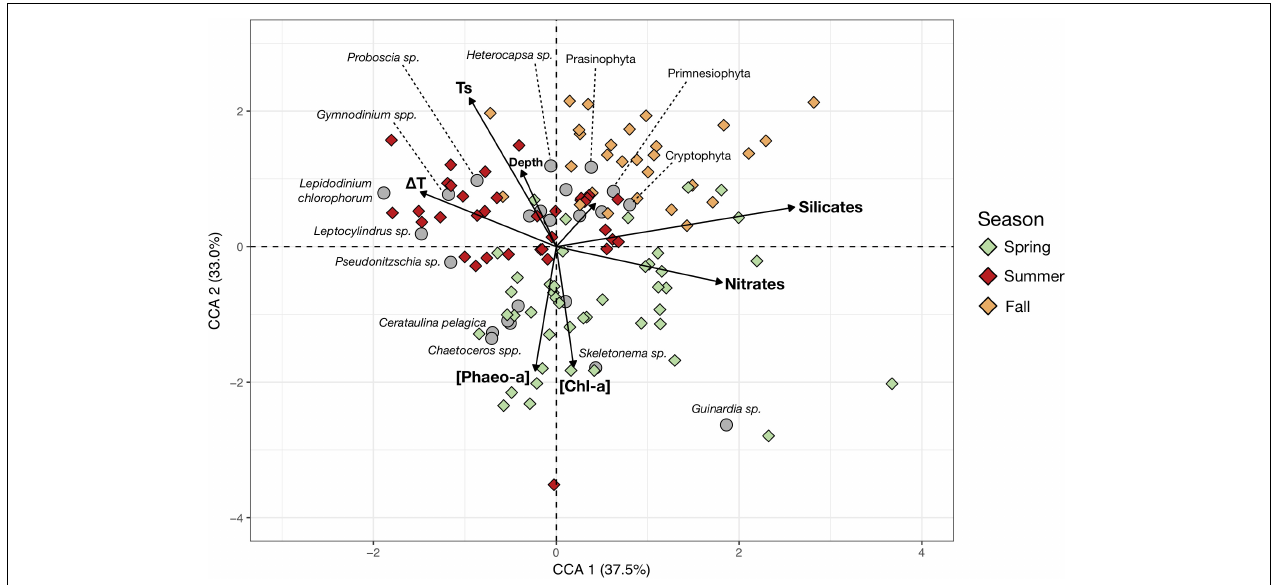
FIGURE 4 | Canonical Correspondence Analysis (CCA) based on the cells counts (cells/mL) of the main phytoplankton species and genera (response variables) and the measured hydrobiological data (explanatory variables, arrows). The color of the symbols corresponding to sampling stations (objects) were colored according to sampling season (Spring, Summer, and Fall). Gray circles represent the mean position of the phytoplankton taxa in the reduced space and therefore indicate the main contributors to the stations community composition. The shortest and unlabelled arrow represents the contribution of phosphate concentrations to ordination of the sampling